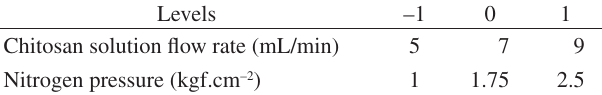
Table 3. Factors used in the design of experiments and their levels.